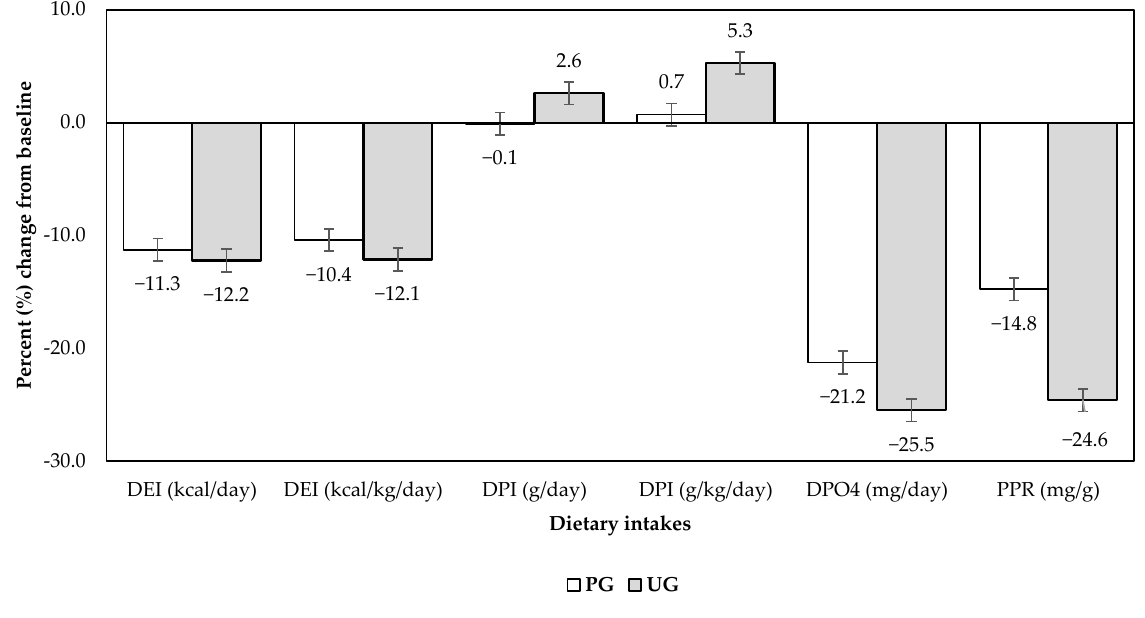
Figure 3. Percent change in dietary intake; p -values for all comparisons were >0.05. Abbreviation: DEI, dietary energy intake; DPI, dietary protein intake; DPO4, dietary phosphorus intake; PG, PMA group; PPR, phosphorus-to-protein ratio; UG, usual care group.